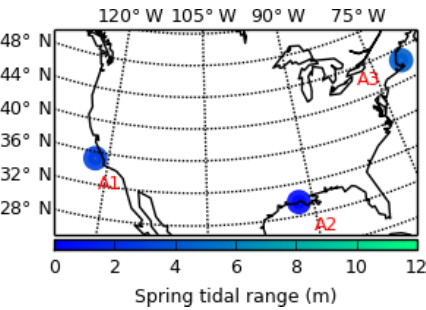
Figure B1. This map shows the three additional sites se- lected from the lidar collection of OpenTopography (http://www. opentopography.org), coloured by spring tidal range. The sites are numbered as follows: A1: Morro Bay, California; A2: Wax Lake